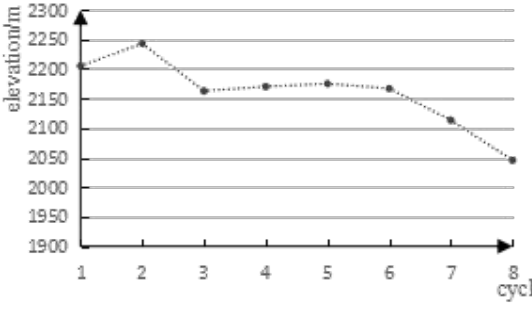
Figure 1. DEM over the cycle in Antarctica